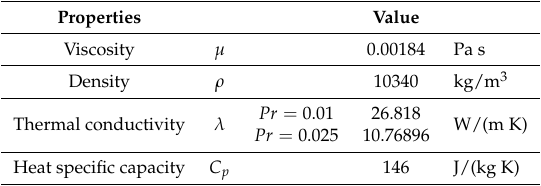
Table 4. Physical properties used in the simulation for Pr = 0.025 and